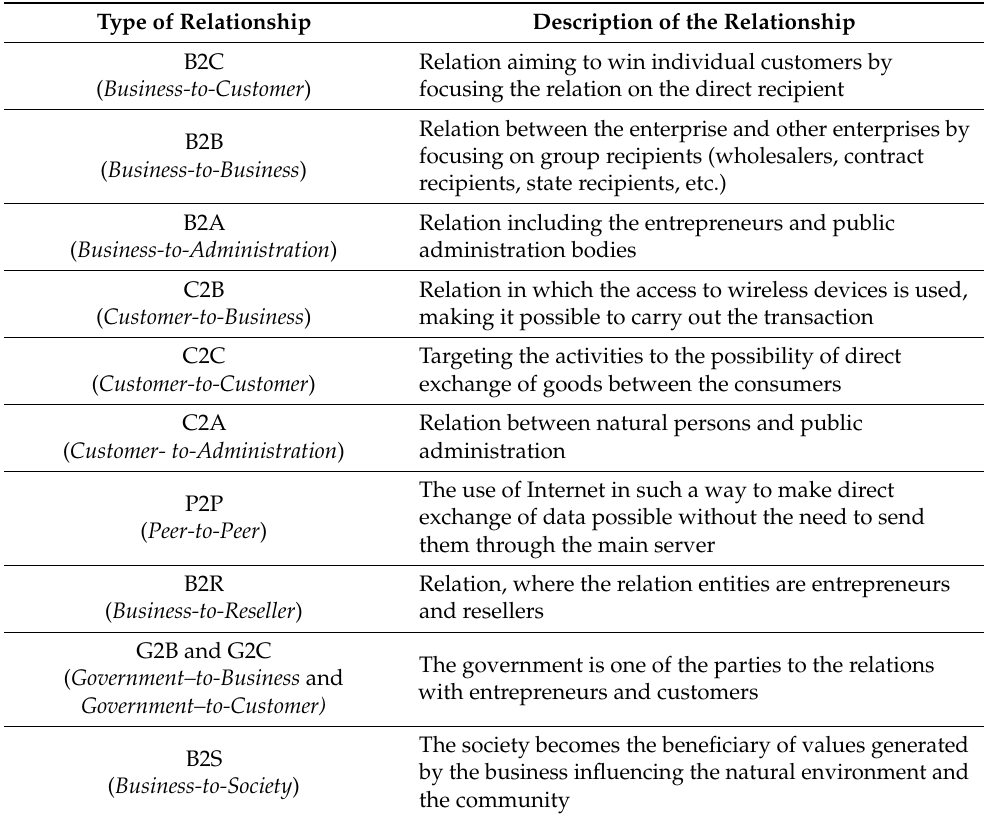
Table 1. Type of relationship in